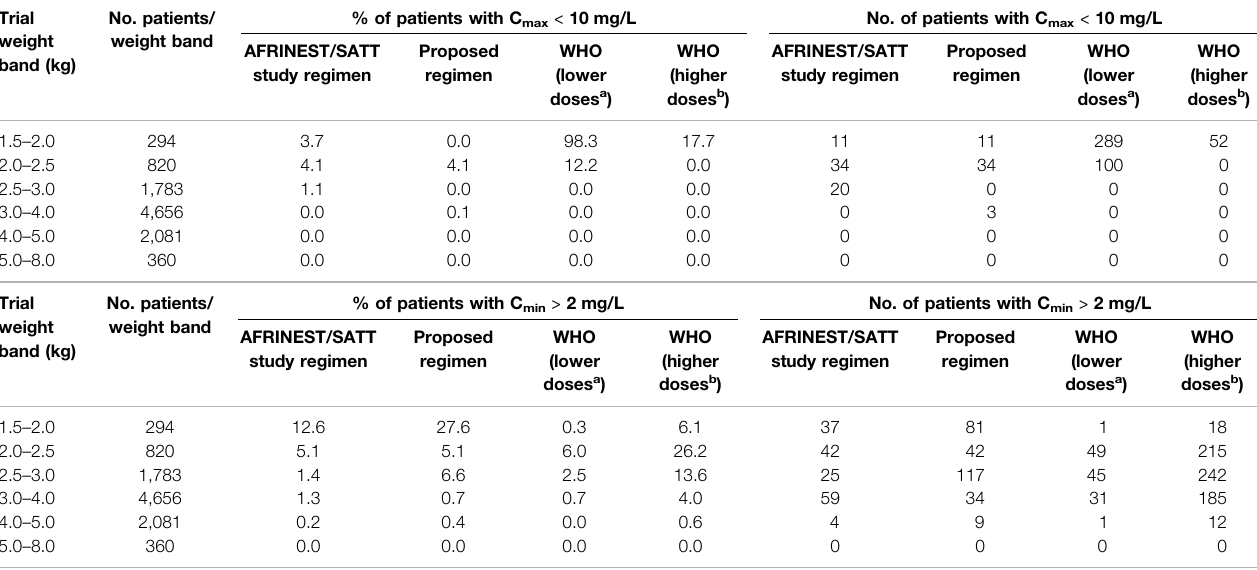
a Lower doses are 3 mg/kg for low birth weight ( < 2.0 kg) newborns and 5 mg/kg for those with body weight > 2.0 kg. b Higher doses are 4 mg/kg for low birth weight newborns and 7.5 mg/kg for those with body weight > 2.0 kg. Data are summarized according to the weight bands used in the